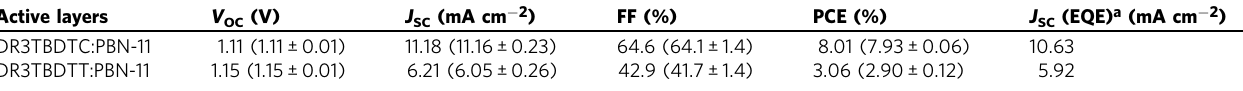
Table 2 Photovoltaic parameters of the OSCs based on DR3TBDTC:PBN-11 and DR3TBDTT:PBN-11 blend fi lms Active